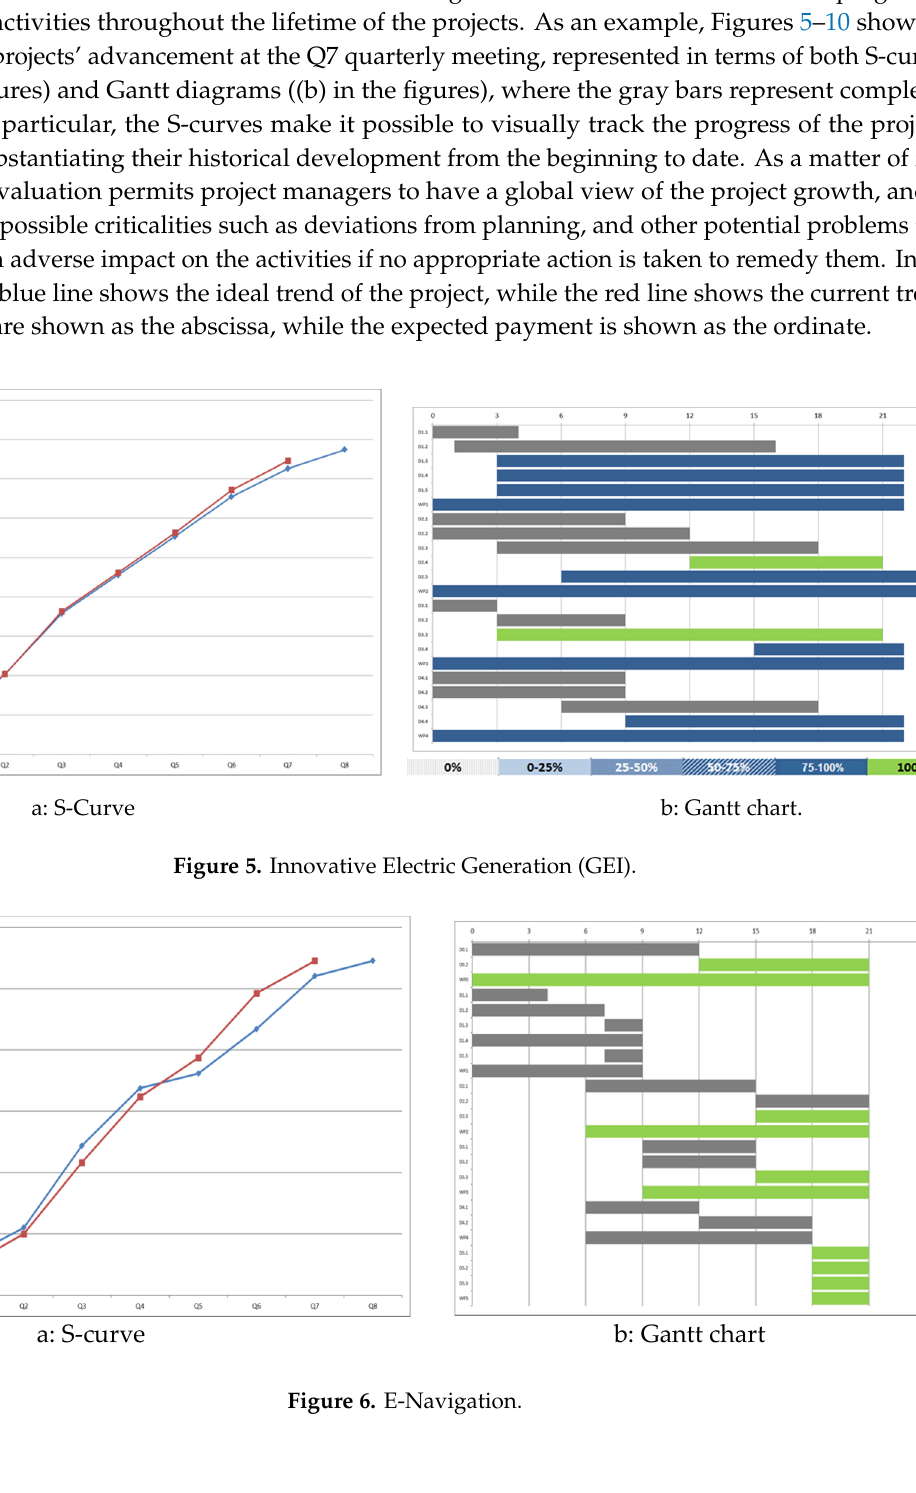
b : Gantt chart Figure 7. E-Cabin .